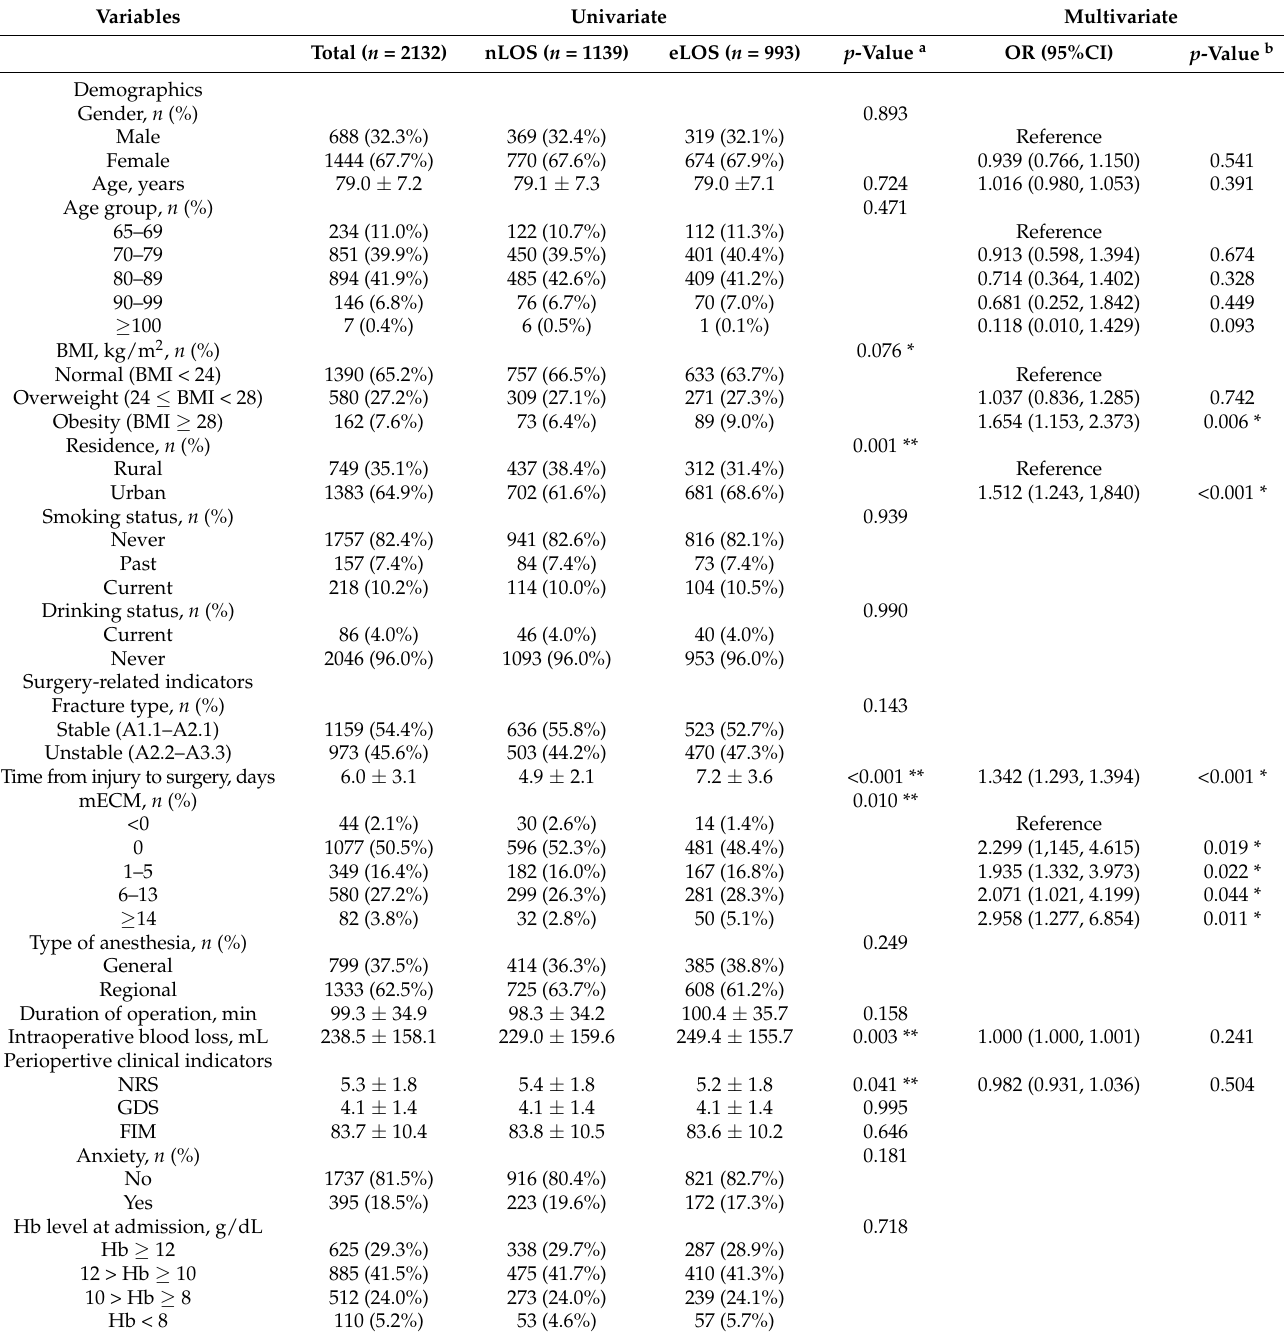
Table 1. The univariate and multivariate analyses of all of the involved possible factors associated with